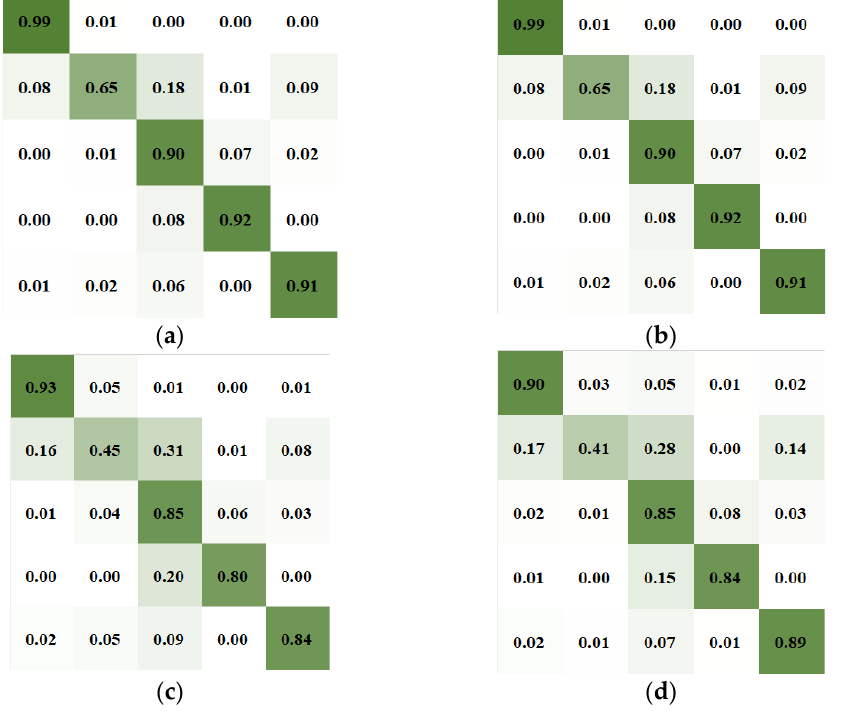
Figure 10. The normalized confusion matrices obtained from the four datasets in our model experi-